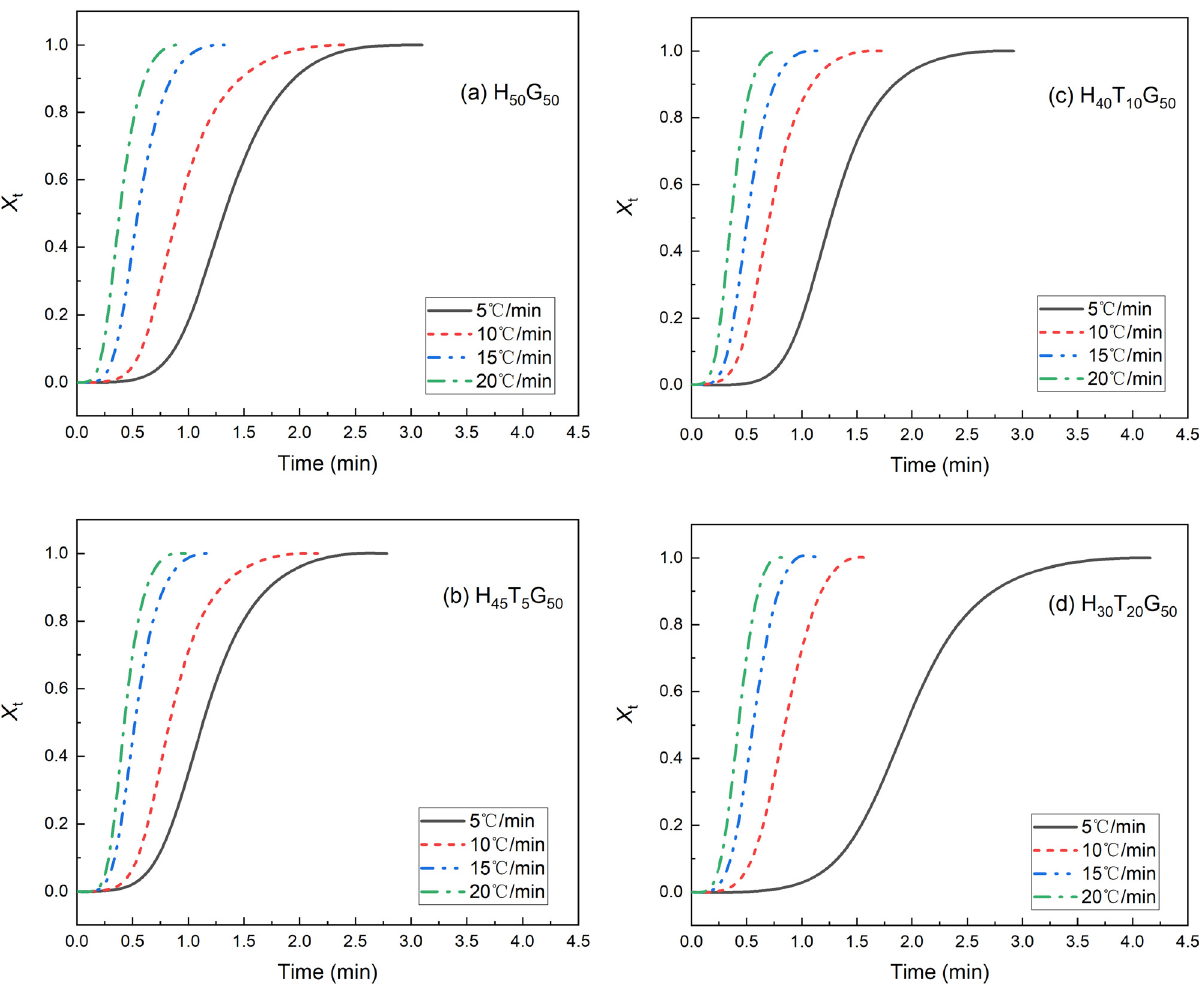
Figure 3: Plots of X t versus t at the cooling rates of − 5, − 10, − 15, and − 20°C · min − 1 for H 50 G 50 ( a ) , H 45 T 5 G 50 ( b ) , H 40 T 10 G 50 ( c ) , and H 30 T 20 G 50 ( d ) ,